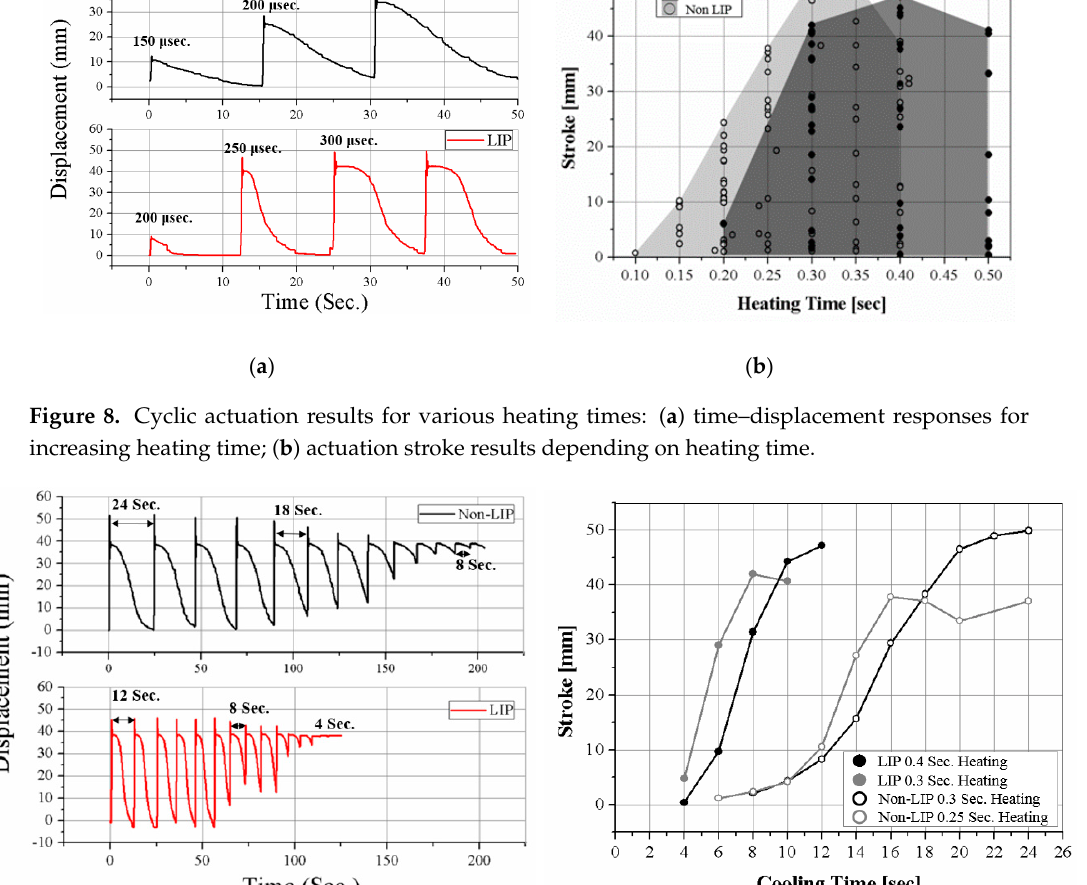
Figure 10. Stroke versus frequency graph merging the experiments with various heating and cooling times. The graph shows the maximum frequency of two SMA coil spring actuators that can produce a full stroke. 8. Conclusions The design framework and modeling provide a clear guideline for the design of the SMA coil spring actuator as an artificial muscle for the soft robot which requires large deformation of the body structure and the actuator. A new practical design methodology for the SMA coil spring actuator is proposed in terms of mechanical design, the wire diameter, the coil diameter and the coil number. The large index and pitch angle (LIP) design maximizes the frequency by improving cooling performance and the efficiency by reducing the mass of the material and input energy. The LIP design method enables production of the required actuation stroke under specific loading conditions with minimum material and maximum frequency. In this paper, the LIP design improved frequency by a factor of 2 and power density by a factor of 12 compared to the non-LIP design but these values are the results from this specific case study and various design of SMA coil spring actuators can be optimized for achieving maximum power density.